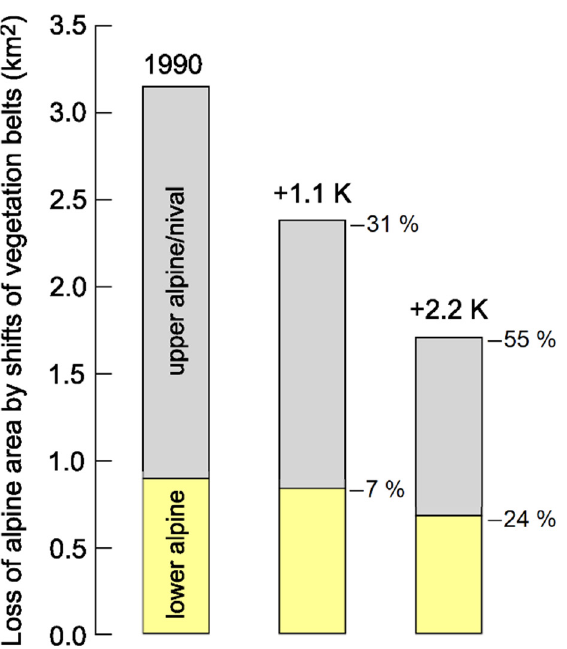
Figure 5. Estimation of the losses of alpine terrain due to the upslope advance of treeline, assuming a new steady state at either +1.1 K (+200 m) or +2.2 K (+400 m of elevation). The lower alpine belt is assumed to shift irrespective of the state of soil development, inevitably diminishing space for the upper alpine/nival belt. The gain in global alpine space due to glacier wasting is too small (globally c. 0.126 Mio km 2 , see the text) to be visualized at that scale (data from